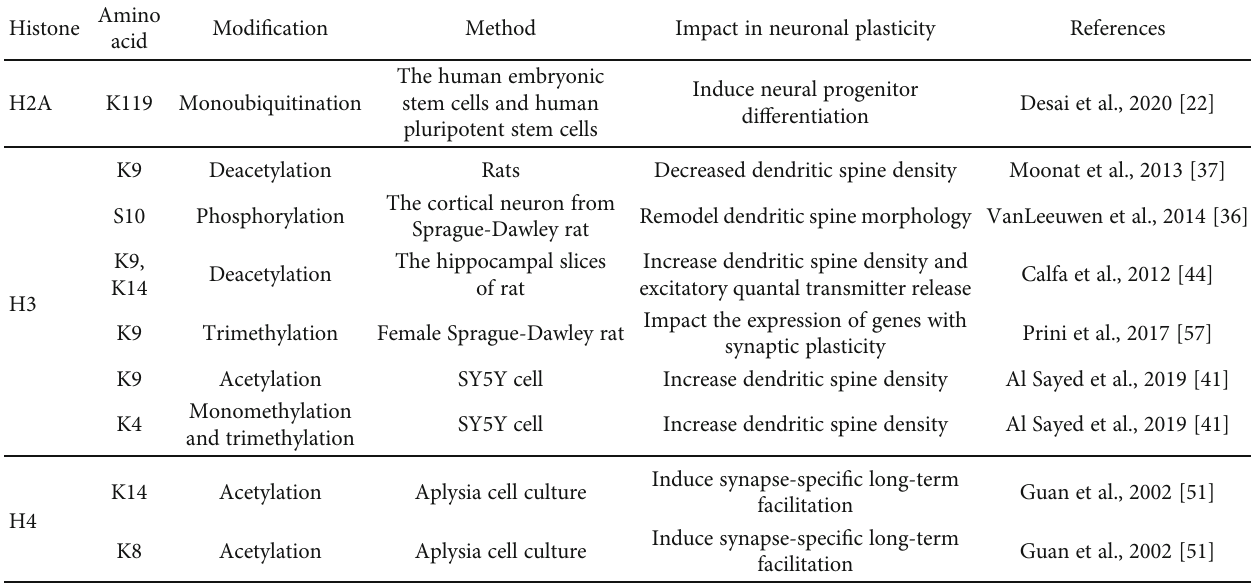
Table 1: The histone modi fi cation in neuronal plasticity.